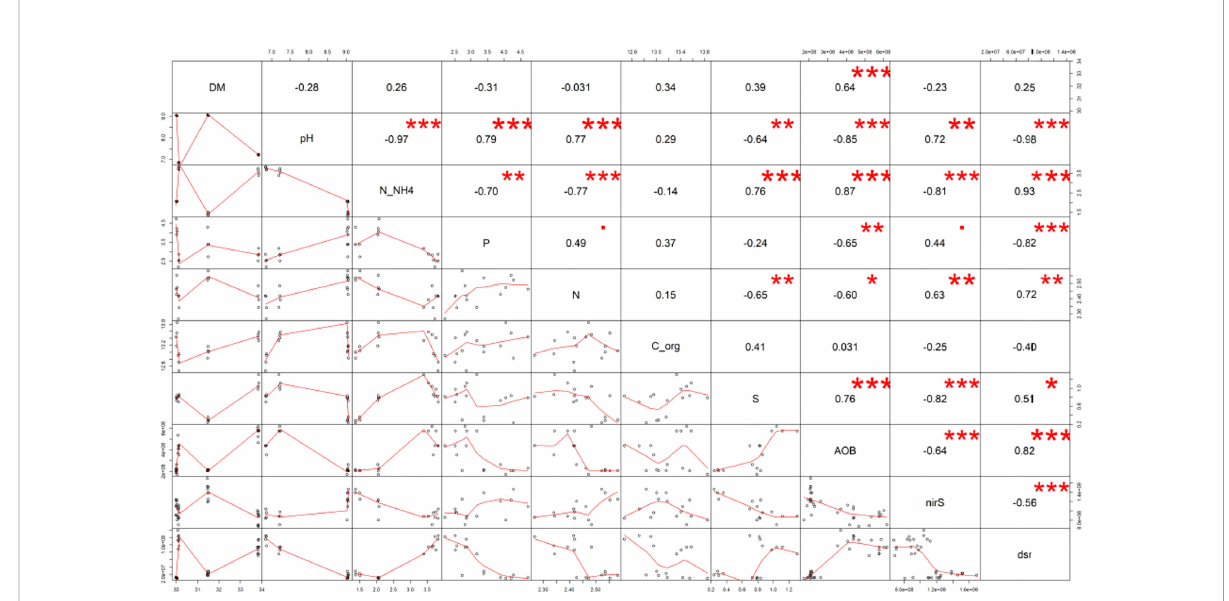
FIGURE 2 The Pearson ’ s correlation matrix of the maturated manure properties. Explanation: Signi fi cance at · p ≤ 0.10; *p ≤ 0.05; **p ≤ 0.01; ***p ≤ 0.001.